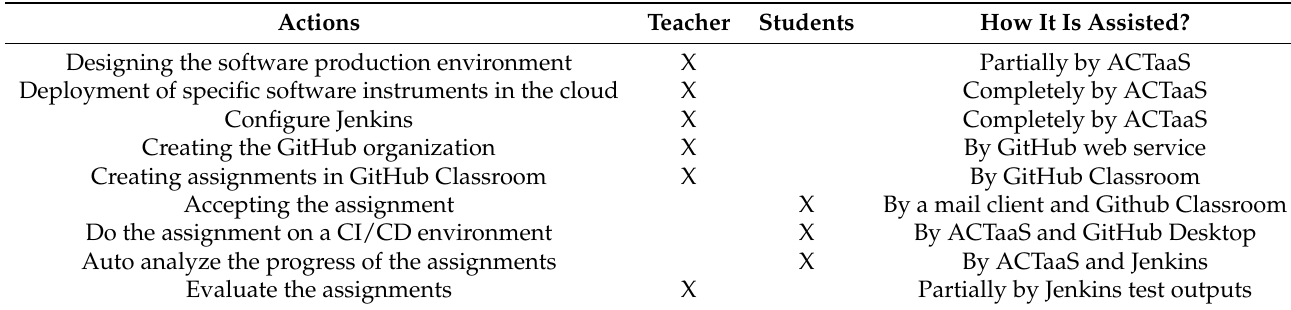
Table 1. Summary of actions to be carried out by the teacher and the students to implement a CI/CD environment in class and the support provided by the proposed